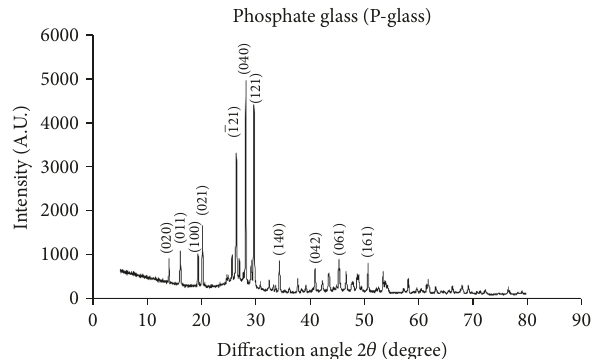
Figure 1: XRD spectra of the P-glass material used in this